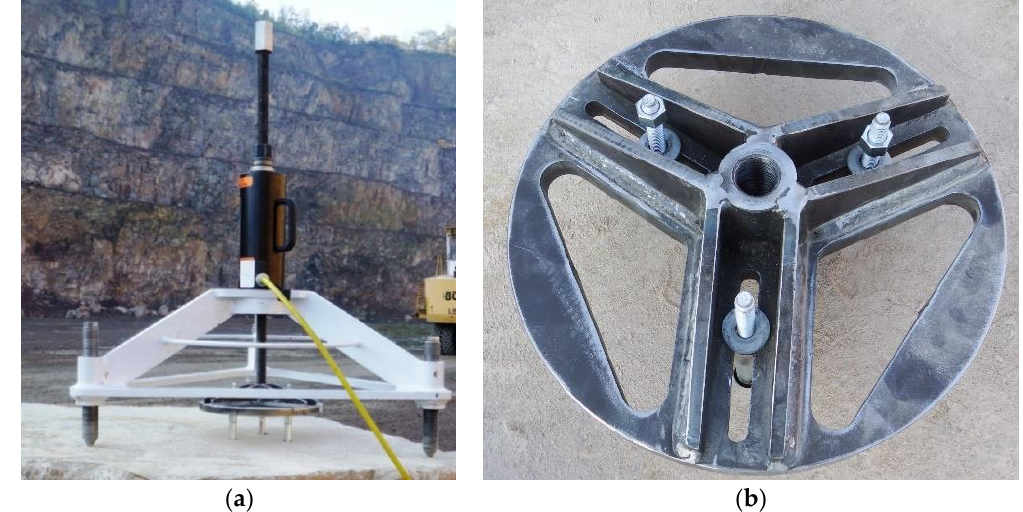
Figure 13. ( a ) Testing instrumentation for the 3-anchor pull-out tests, ( b ) the 3-anchor anchorage circle.